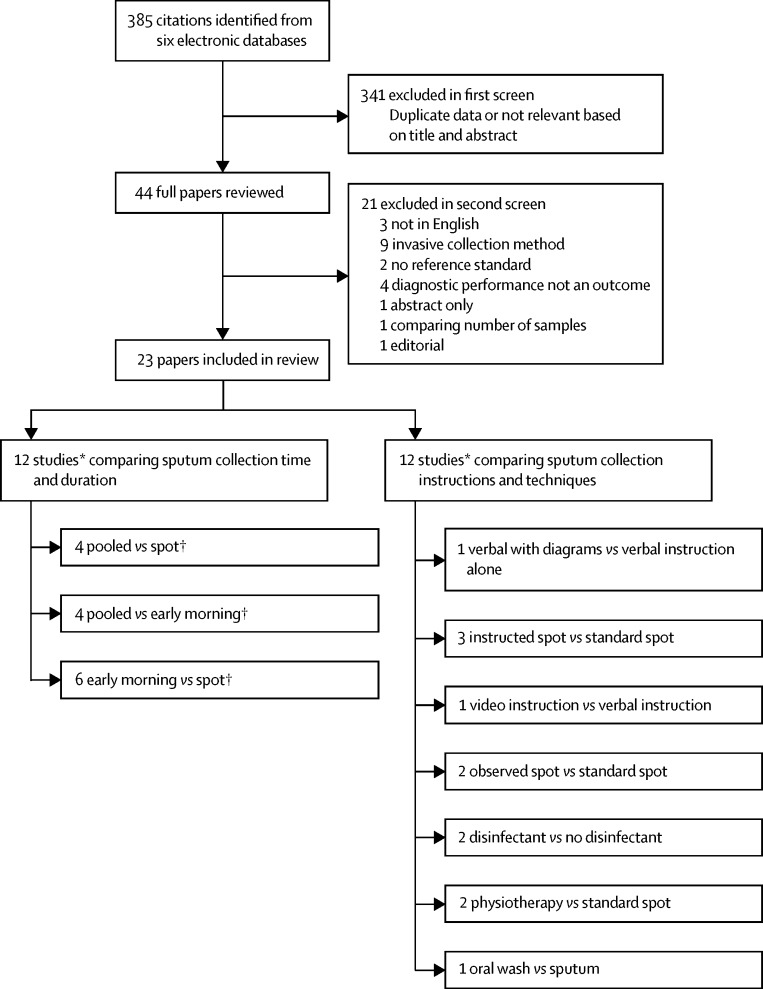
Study selection*Findings from one study contributed to assessment of both aspects of collection methods: sputum collection time and duration; and sputum collection instructions and techniques. †One study compared pooled sputum collection versus spot sputum collection versus early morning sputum collection, and was therefore included in all meta-analyses comparing sputum collection time and duration.